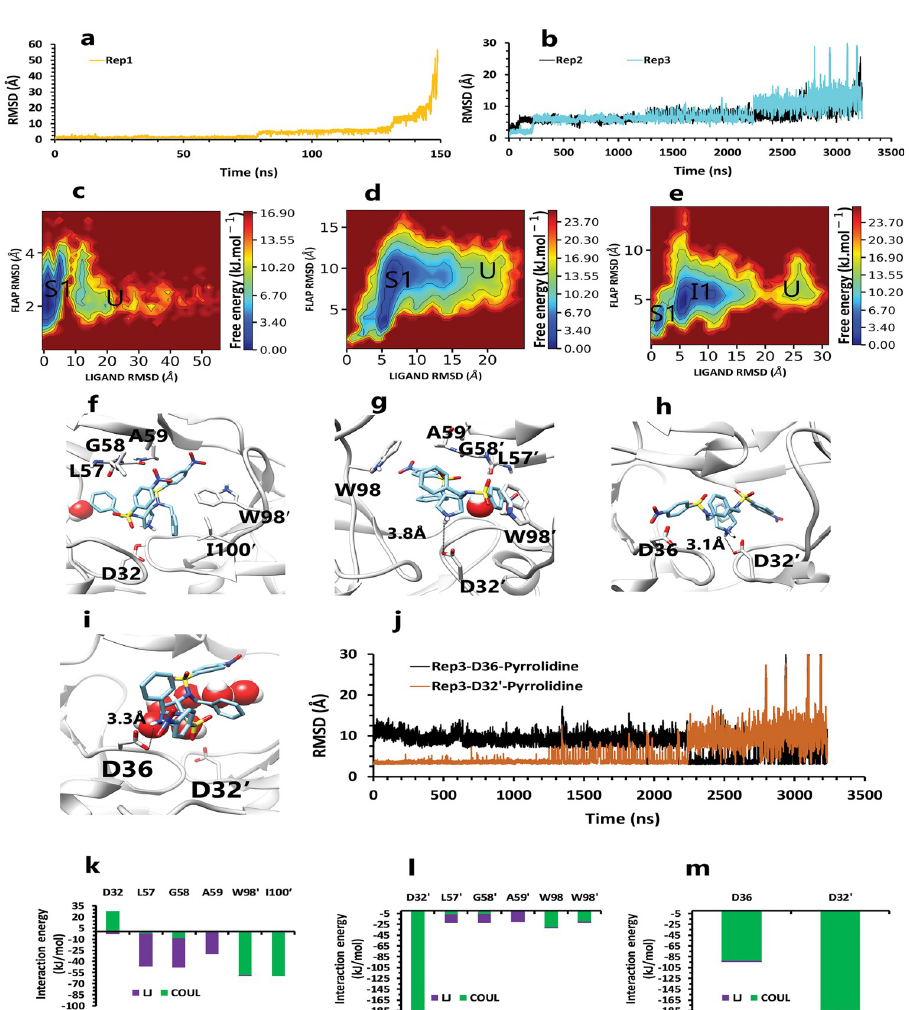
Fig 10. The details of compound 9 unbinding pathways in complex with HTLV-1 protease when Asp32 of chain A was protonated in three replicas. A , RMSD value of the ligand from binding pose to complete unbinding in the rep1. B , RMSD values of the ligand from binding pose to complete unbinding in the rep2 and rep3. C , D , and E , The free energy landscape of rep1, 2, and 3 during the unbinding process (state (S), intermediate state (I), unbound (U)), respectively, which was calculated by using "gmx sham". F , The interactions between the ligand and essential active site residues in the rep1. G , The interactions between the ligand and essential active site residues in the rep2. H , The interactions between the ligand and essential active site residues in the binding pose of rep3. I , The new interactions between the inhibitor and particular residues in the second intermediate state of rep3. J , The distance between COMs of pyrrolidine ring and Asp36 and Asp32 0 in rep3, to show after 2us of simulation this fragment get closer to Asp36 and get farther from Asp32 0 . K , L , and M , The average of most important interaction energies of the protein-ligand complex in rep1, 2, and 3,